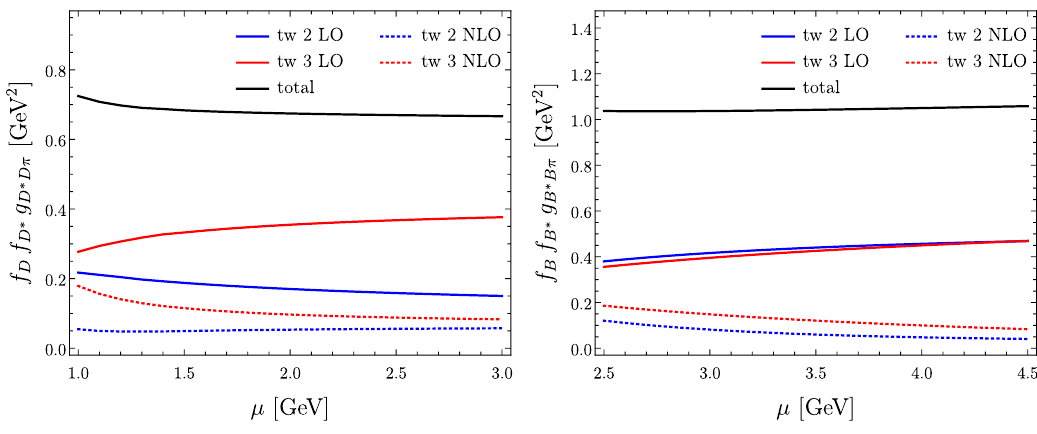
Figure 2 . Scale dependence of the products f D f D ∗ g D ∗ Dπ and f B f B ∗ g B ∗ Dπ calculated from LCSR. Displayed are the total values and separate twist-2 and twist-3 contributions for Model 1 of the twist-2 pion DA and at central values of all other input